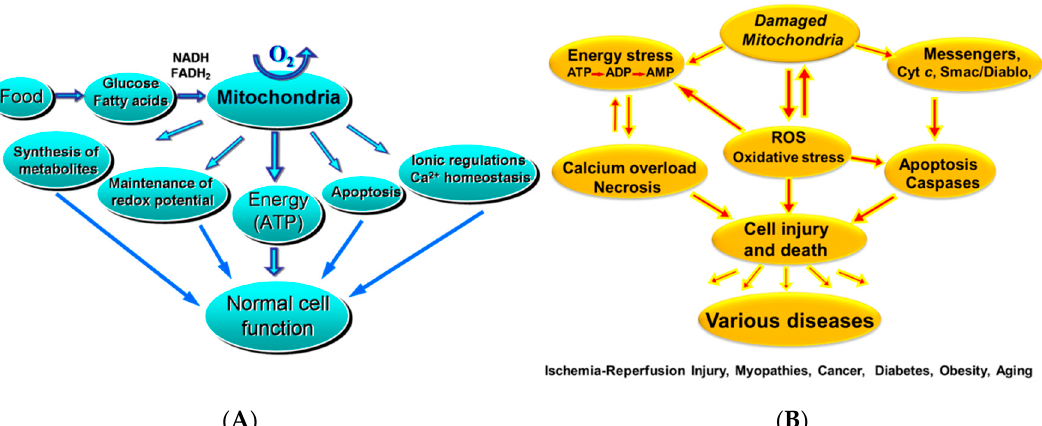
Figure 1. ( A ) The roles of mitochondria in normal cell function; and ( B ) in various cell damage / injuries. Mitochondrial function and dysfunction contribute to cell viability and injury by several mechanisms. ROS—reactive oxygen species.